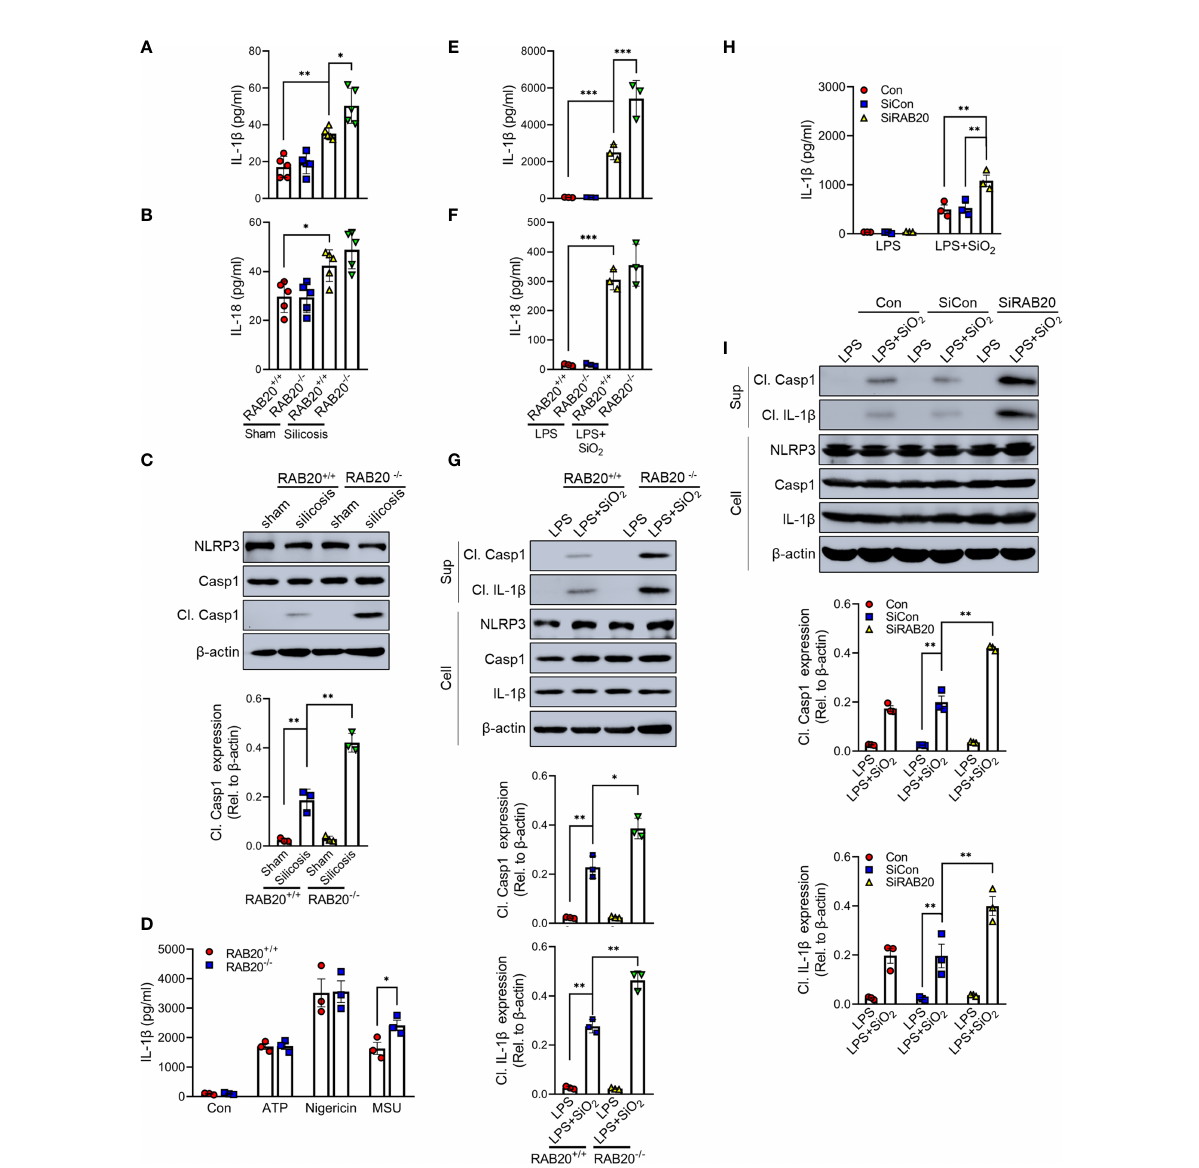
FIGURE 3 RAB20 de fi ciency promotes silica crystal-induced activation of NLRP3 in fl ammasome. (A, B) IL-1 b and IL-18 levels in bronchoalveolar lavage fl uid cells of wild type or RAB20 knockout mice with or without silica crystals. (C) Immunoblotting for caspase-1, NLRP3, and b -actin in the lung tissues of wild type and RAB20 knockout mouse stimulated with or without silica crystals. (D) IL-1 b secretion in wild type and RAB20 knockout peritoneal macrophages stimulated with ATP, nigericin, and MSU after LPS priming. (E, F) IL-1 b and IL-18 secretion in wild type and RAB20 knockout peritoneal macrophages stimulated with SiO 2 after LPS priming. (G) Immunoblotting for IL-1 b , caspase-1, NLRP3, and b -actin in the supernatants (SN) or cell lysates (cell) of wild type and RAB20 knockout mouse peritoneal macrophages stimulated with SiO 2 after LPS priming. (H) IL-1 b secretion in THP1 cells with RAB20 siRNA and then stimulated with SiO 2 after LPS priming. (I) Immunoblotting for IL-1 b , caspase-1, NLRP3, and b -actin in the supernatants (SN) or cell lysates (cell) of THP1 cells with RAB20 siRNA and then stimulated with SiO 2 after LPS priming. *p < 0.05; **p < 0.01; ***p < 0.001 (unpaired/two-tailed t test, one-way and two-way ANOVA test). Data are shown as mean ± SEM from three independent